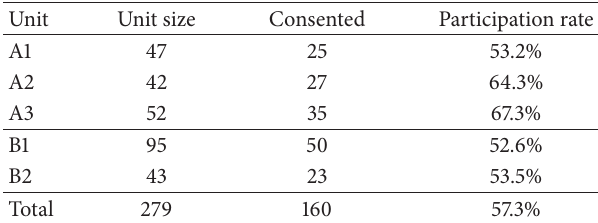
Table 1: Study participation.